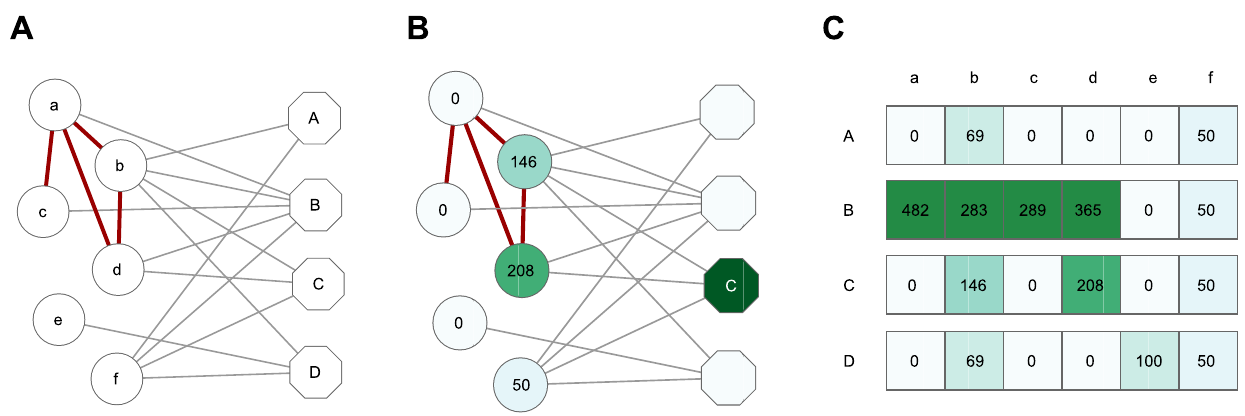
Figure 1. Obtaining information flow weights. We first construct a protein-complex graph where each complex is linked to its members ( A ). The hexagonal nodes labelled with upper case letters here denote complexes, while the circular nodes labelled with lower case letters denote proteins. The grey edges represent memberships of proteins within complexes, while red edges are direct protein-protein interactions. For each protein member of a given complex (complex C used here as an example), we evaluate its number of visits under our model ( B ). The numbers of visits (multiplied by 100 ) are shown on the protein nodes and also indicated by color (darker means larger values). The computed numbers of visits for all proteins constitute the ITM weight functions ( C ), which are used to construct the DAG. The values are multiplied by 100 . This example uses b ~ 0 : 85 m ~ 2 and n ~ 3 . Note that the weights for proteins b and d are smaller in the complex C than in B, because B also includes their direct interaction partner a. Also observe that the proteins b and f are downweighted because they belong to 4 complexes while m is set to 2 .